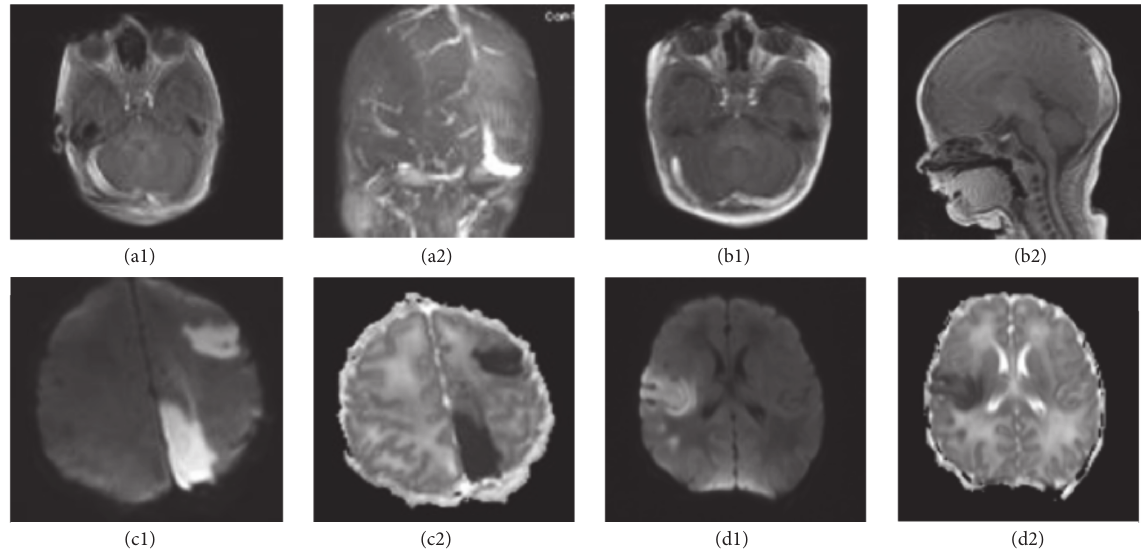
Figure 1: (a1, a2) Preterm neonate with severe perinatal depression born to mother with no prenatal care: the MRI and MRV images, respectively, show venous sinus thrombosis involving the entire right transverse and sigmoid sinus, most of the straight sinus, and the medial aspect of the left transverse sinus. In this case low molecular weight heparin was initiated. (b1, b2) Term neonate with sepsis, hyperthermia, and suspected episodes of seizures. On T1 images there was an abnormal signal intensity in the lower superior sagittal sinuses as well as bilateral transverse sinuses, consistent with CSVT. A small amount of intraventricular hemorrhage in the posterior body and atrium of the right lateral ventricle was also identified. Infant’s coagulation work-up was negative for any major clotting disorder. (c1, c2) Diffusion weighted images (DWI) as well as ADC Map are shown for a term neonate with no identified risk factors that presented with seizures. (d1, d2) An IUGR infant admitted to the NICU due to suspected apnea and respiratory distress. An MRI without contrast demonstrated a moderately sized acute cortical infarct in the right middle cerebral artery territory, involving the right posterior frontal lobe and frontoparietal junction at the region of the motor